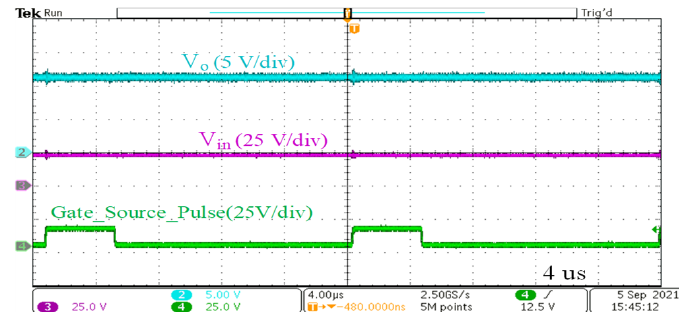
Figure 14. Bucking case study, where the input voltage is 23 V, output voltage is 9.25 V, duty cycle is 0.2244, and voltage gain is 0.4.